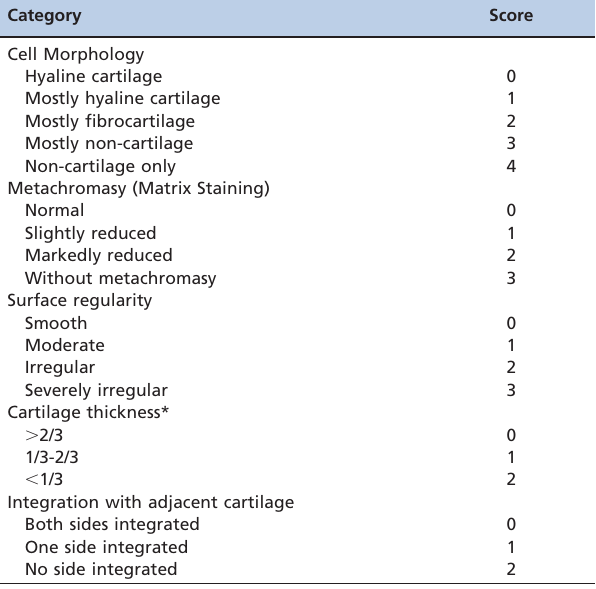
Table 1 - Histological Grading Scale (Wakitani et al. (27)).